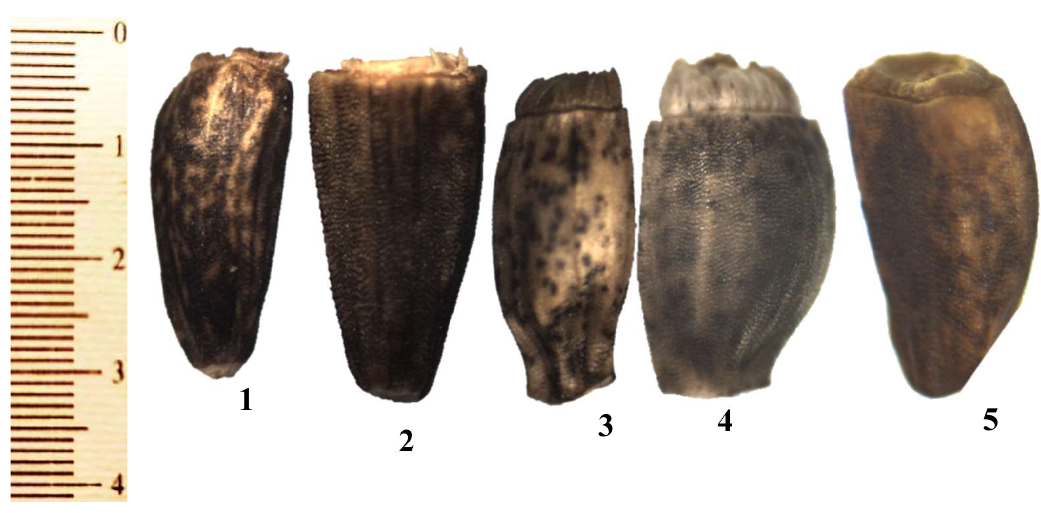
Figure 2. Light micrographs of cypsela and pappus in Cichorium : ( 1 ): C. intybus var. intybus ; ( 2 ): C. intybus var. foliosum ; ( 3 ): C. endivia var. endivia ; ( 4 ): C. endivia var. crispum ; ( 5 ): C. endivia subsp. pumilum .